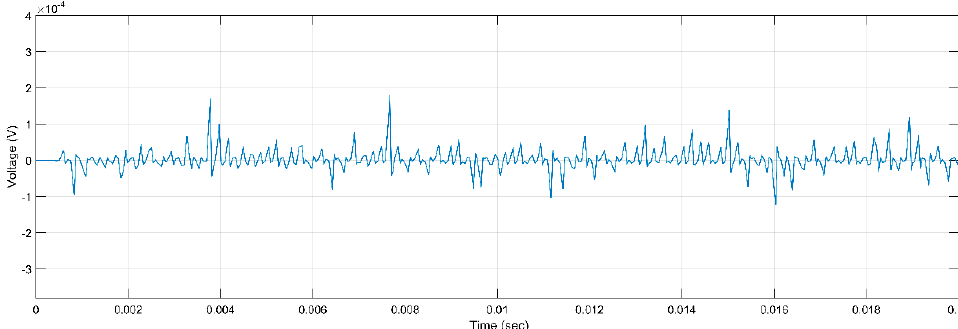
Figure 16. PD Activity for Mica, 5 kV, h, r.